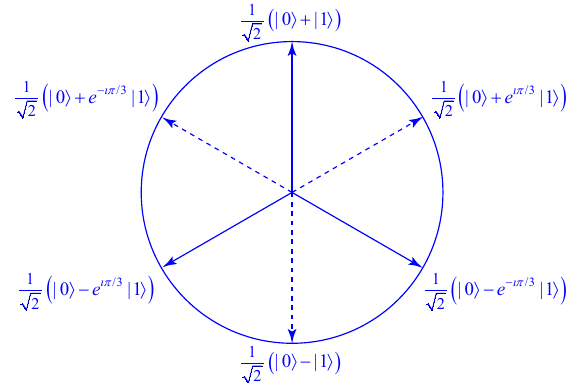
Figure 11: A set of nonorthogonal states that can be antidis- tinguished, and the POVM that antidistinguishes them. The diagram represents the equator of the Bloch sphere and the three antidistinguishable states are shown by the solid arrows. The dashed arrows show three states that are each orthogonal to one of the states in the antidistinguishable set. A POVM can be formed by scaling the projectors onto the three dashed states by a factor of 2 / 3 . By virtue of the orthogonality relations, this is an antidistinguishing